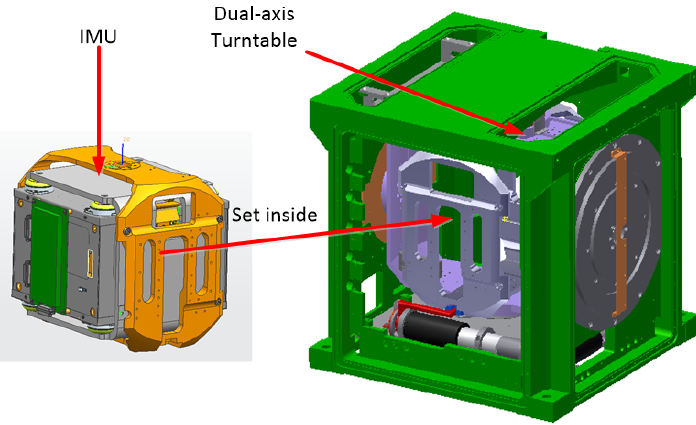
Figure 4. Structure of the Dual-axis RINS.